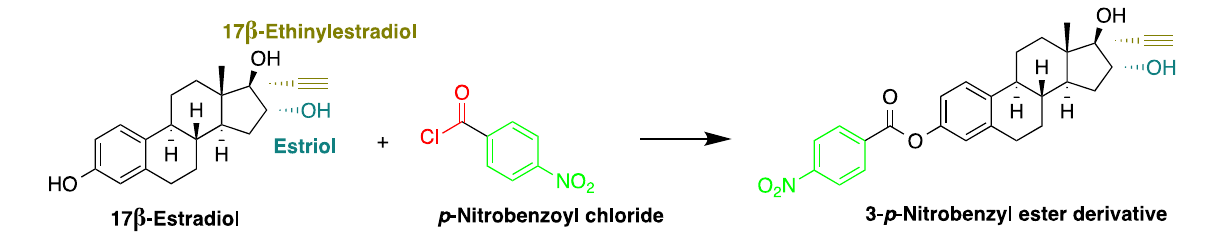
Figure 14. Derivatization of 17 β -estradiol by p -nitrobenzoyl chloride.